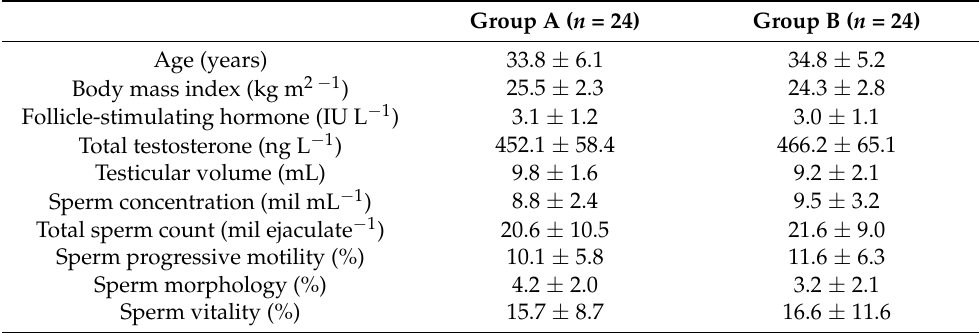
Table 1. Baseline